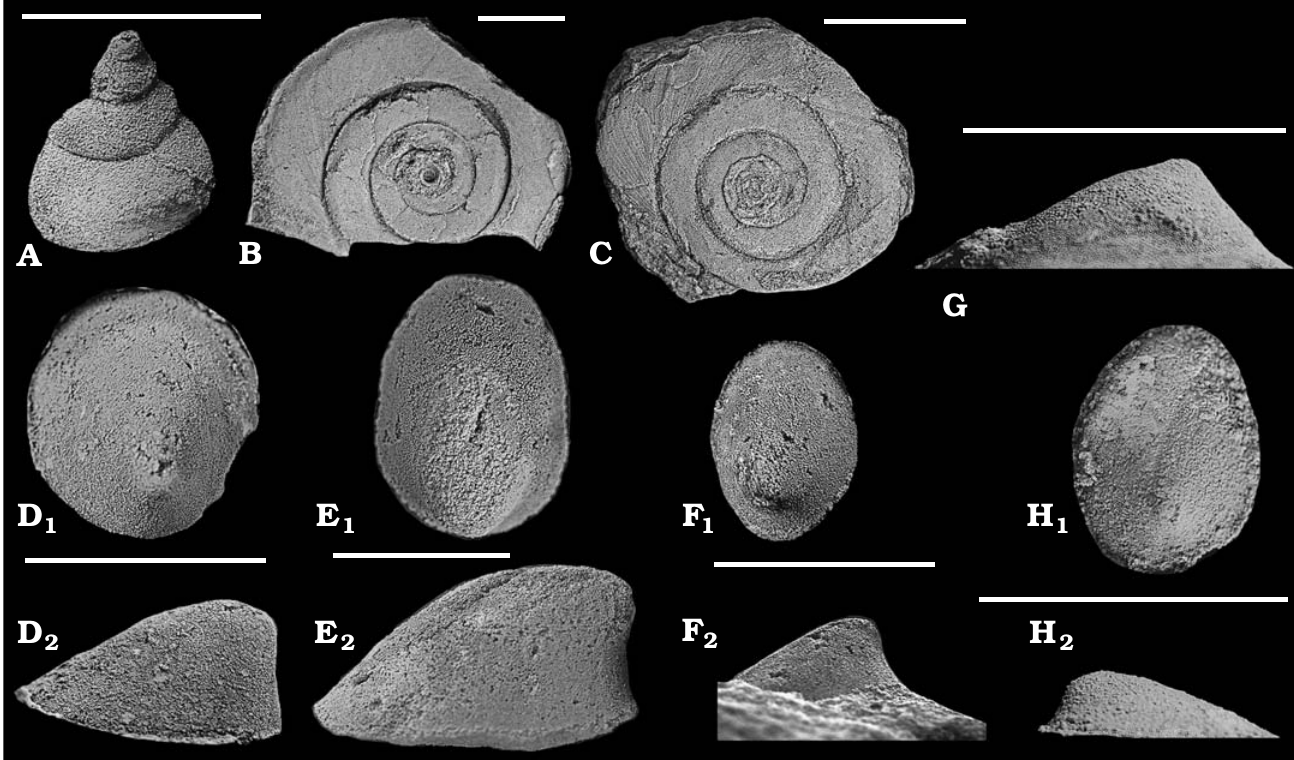
Fig. 13. Gastropods from the Stairway Sandstone, Middle Ordovician, Australia. All internal moulds. A . Raphistomina ? sp. from Areyonga Gorge with 4 whorls (CPC 41496). B , C . Teiichispira ? sp. from loose samples from Petermann Creek; with a very flat base, perhaps 5 whorls present ( B , CPC 41497; C , CPC 41498). D , E . Archinacelloid sp. A ( D , CPC 41499; E , CPC 41500) from Petermann Creek; with slightly concave subapical surface and steeply inclined slightly curved apex, in anterior (D 1 , E 1 ) and left-lateral (D 2 , E 2 ) views. F , G . Archinacelloid sp. B from Areyonga Gorge (F) and Petermann Creek (G). F . Specimen with subcentral and sharply pointed apex (CPC 41501), in anterior (F 1 ) and left-lateral (F 2 ) views. G . Specimen with subcentral and pointy apex (CPC 41502), in left-lateral view. H . Archinacelloid sp. C from Petermann Creek with low shell profile and inclined slightly curved apex (CPC 41503), in anterior (H 1 ) and left-lateral (H 2 ) views. Scale bar 10